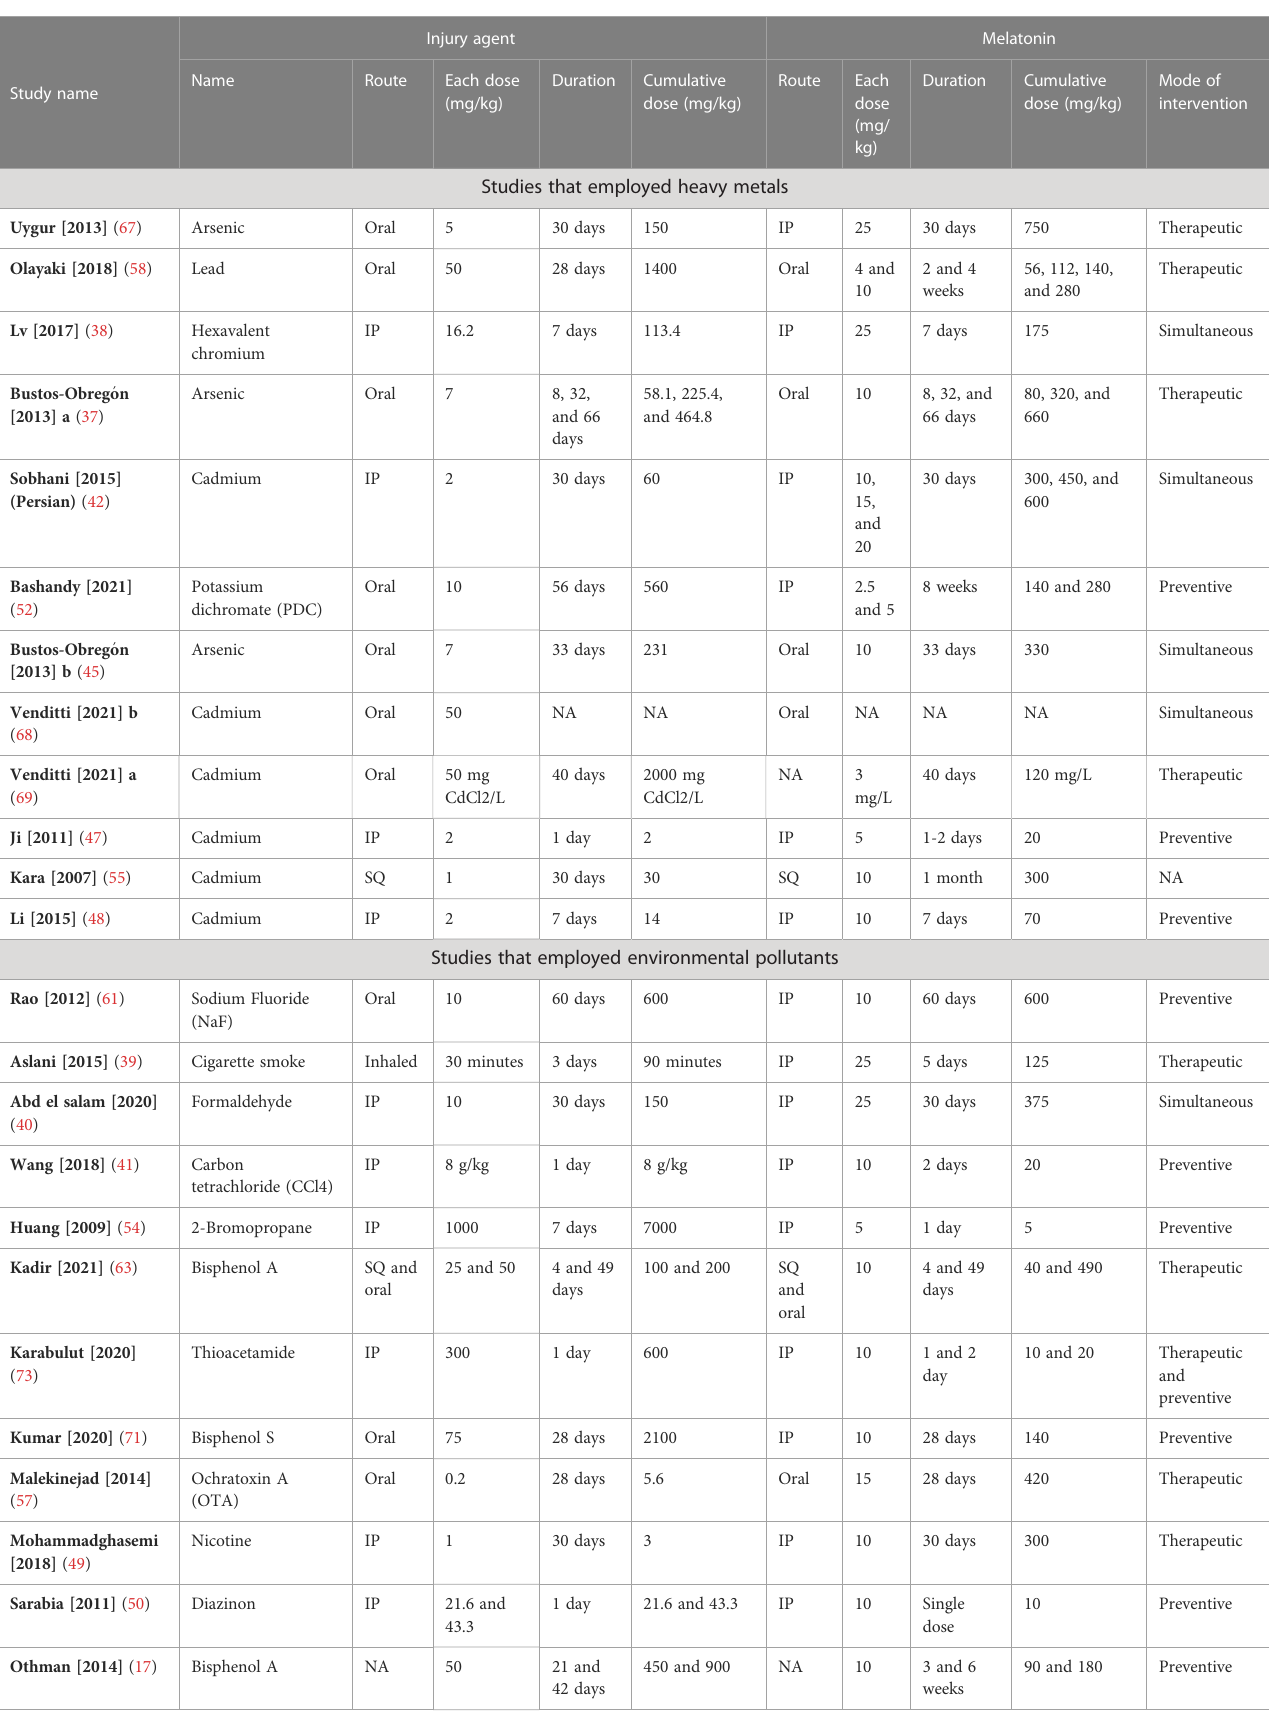
TABLE 2 Details on experimental designs of each included